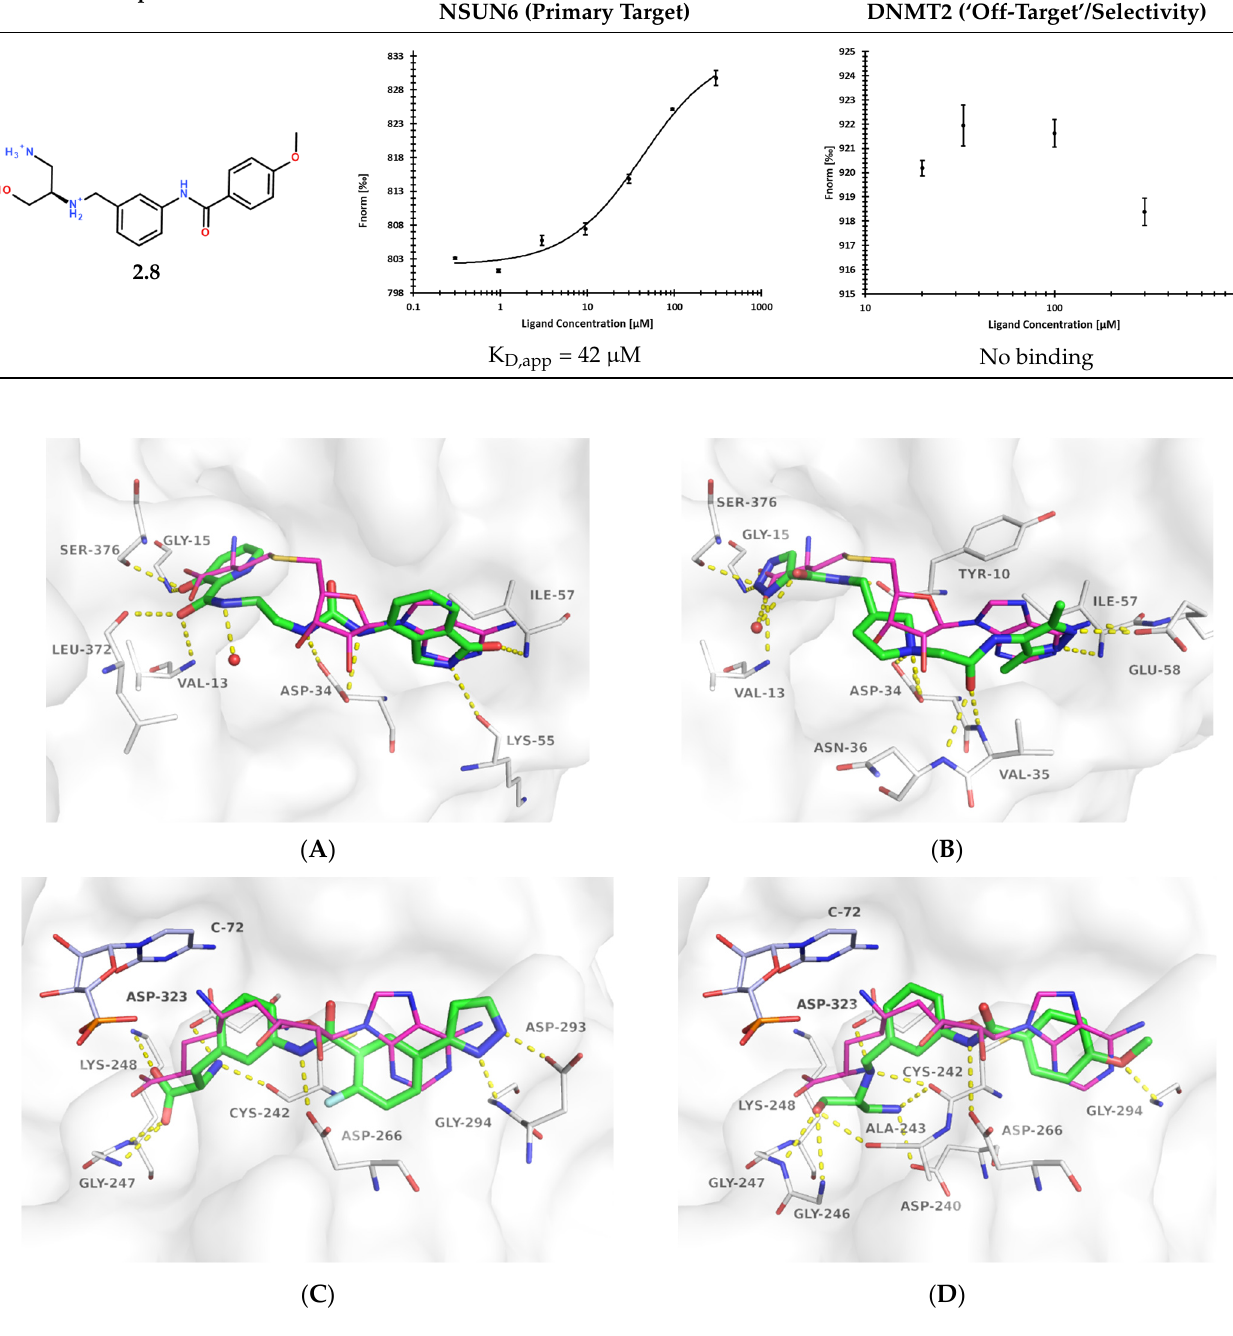
Figure 4. Predicted binding modes of 1.4 in complex with DNMT2 ( A ), 1.18 in complex with DNMT2 ( B ), 2.5 in complex with NSUN6 ( C ), and 2.8 in complex with NSUN6 ( D ). Docking poses are depicted with green carbon atoms, enzymes with white carbon atoms, and transparent surfaces. For a clear view, only residues forming polar interactions (yellow dashed lines) are shown and labeled. For orientation, the crystallographic reference ligands SAH (DNMT2, PDB-ID 1G55) and SFG (NSUN6, PDB-ID 5WWR) are shown with magenta carbon atoms. In NSUN6, C-72 is depicted with light blue carbon atoms for orientation, but tRNA was removed during molecular